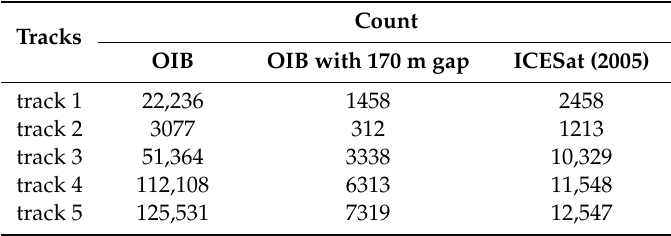
Table 1. Comparison of count number among Operation IceBridge (OIB) with and without a 170 m gap and ICESat data (taking 2005 as an